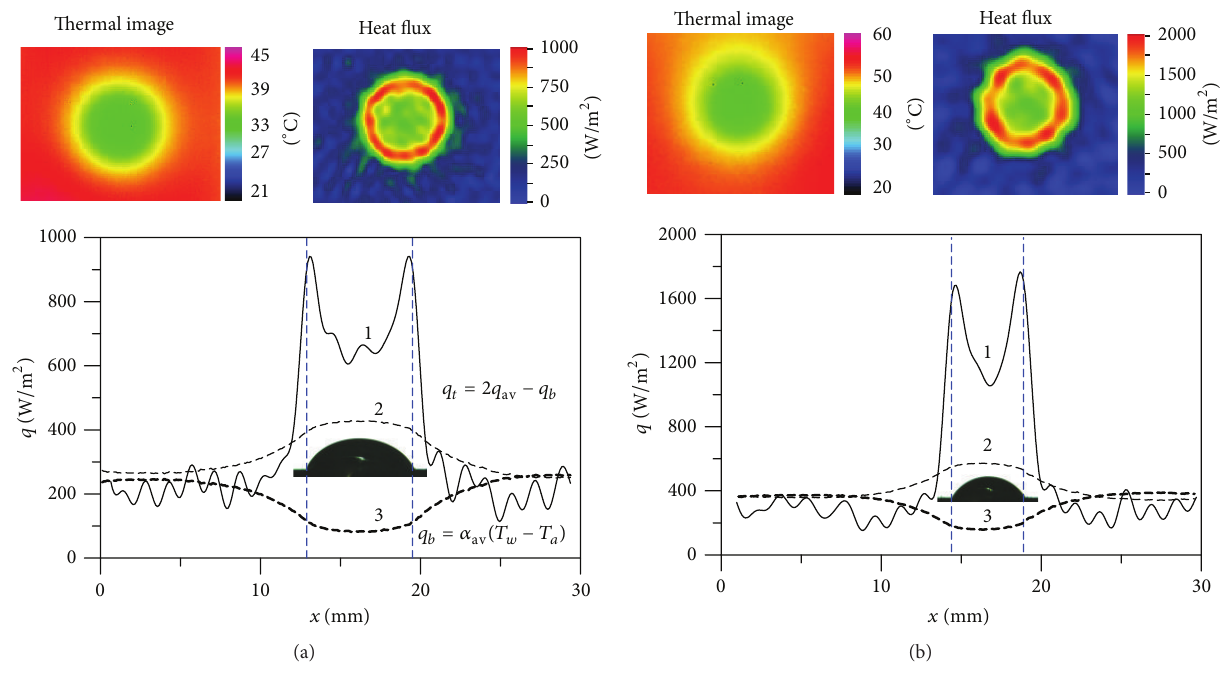
Figure 3: Distributions of heat flux density: 1: Cauchy problem solution. 2: calculation with neglecting of heat flux redistribution in the foil, 𝑞 𝑡 . 3: on the bottom side of foil, 𝐻 = 1.15 mm, 𝑉 = 9.8 𝜇 L, 𝜃 = 59 ∘ , and 𝑞